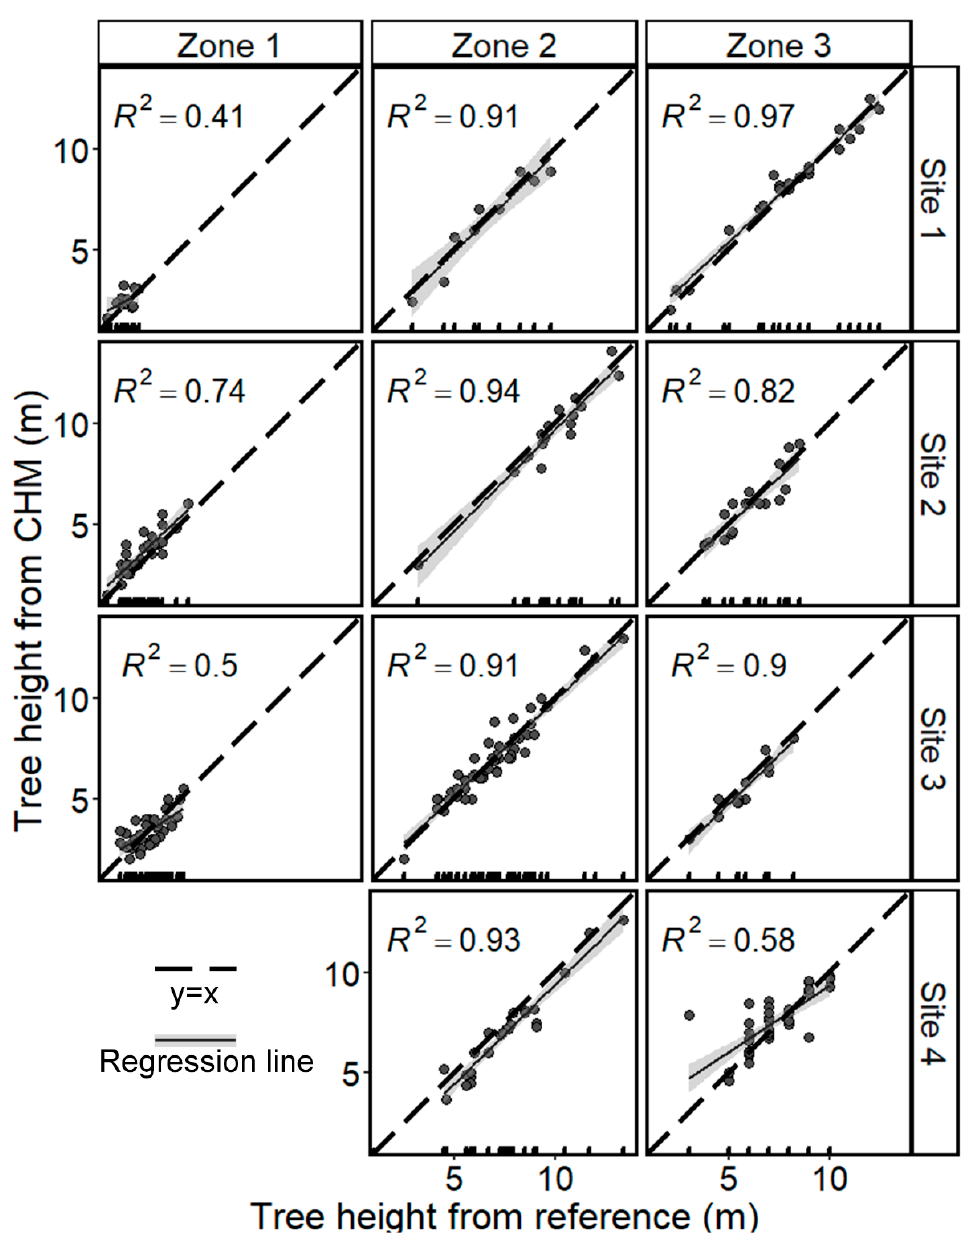
Figure A1. Site-specific comparison of H from CHM with actual measured values (reference values) in trees with high stand form.